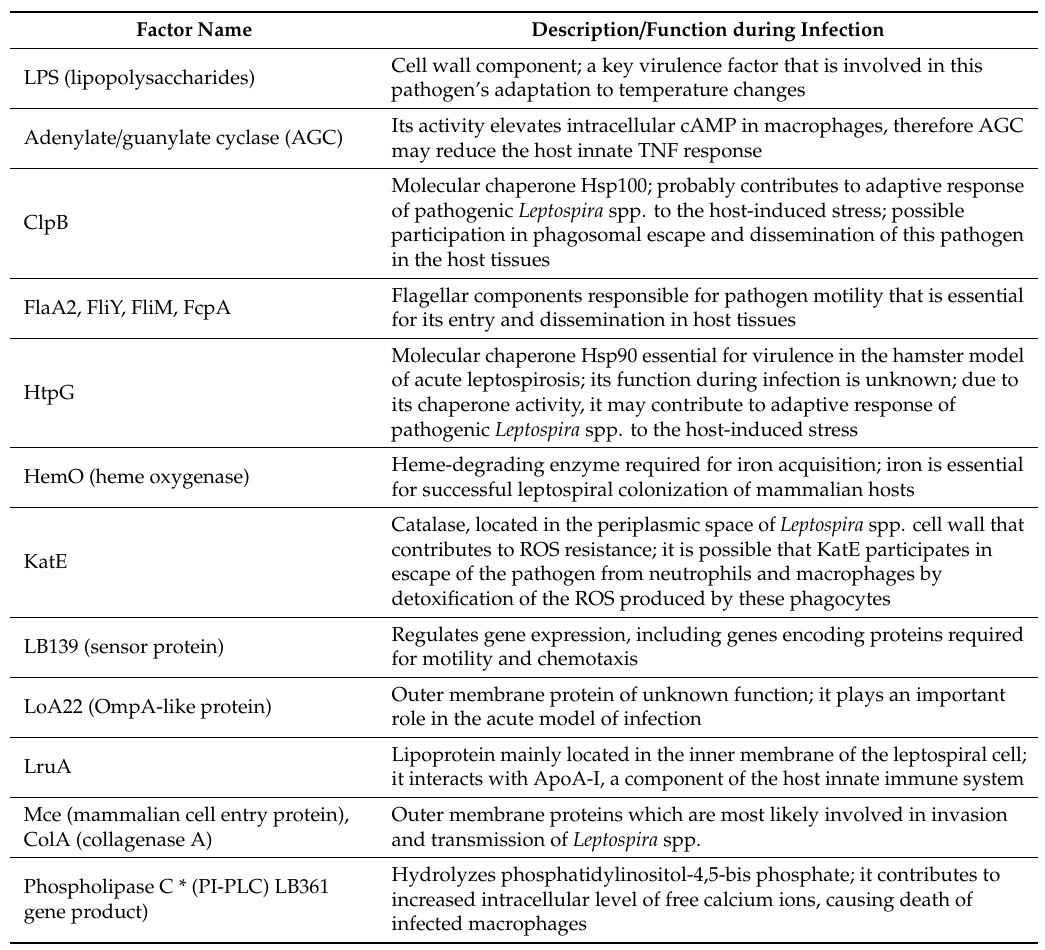
Table 1. Known virulence factors of L. interrogans identified in animal models of acute leptospirosis and in in vitro macrophage models *